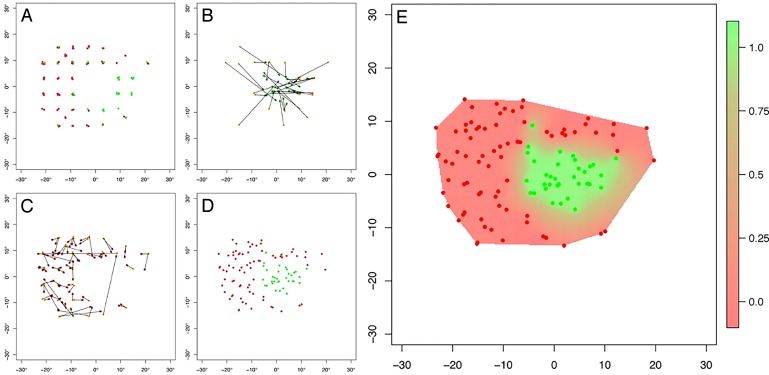
Computing performance using Eyecatcher. (A) Initially Eyecatcher attempted to present four stimuli at each of the 44 test locations in the underlying measurement grid (Fig. 1B). For each trial, the participant's response was scored as either a hit (green dots), or a Miss (red dots – NB: the location of each dot has been jittered slightly for visibility). (B, C) To correct for eye movements, after each trial (and irrespective of whether it was scored as a Hit or a Miss), the software searched back 200 ms, and used the participant's gaze location at this prior time point to replace the intended stimulus location (orange dots) with its true location (green/red dots). (D) The empirical test grid, after post hoc correction (same data as [A]). Due to the correction for eye movements, the precise shape and extent of this map is liable to differ on every test. (E) Finally, Kriging42 was used to interpolate the corrected data to provide a continuous heatmap indicating the Probability of Seeing at each location (red: highly unlikely; green: highly likely). Kriging was performed in R, using the Fields package.43